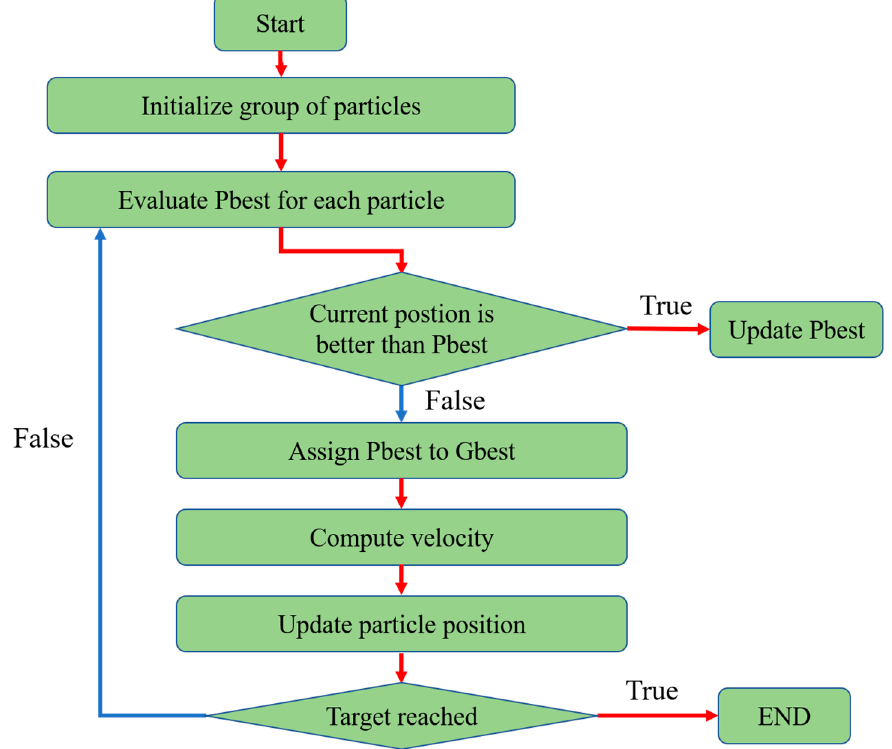
Figure 11. Conceptual representation of the PSO algorithm.